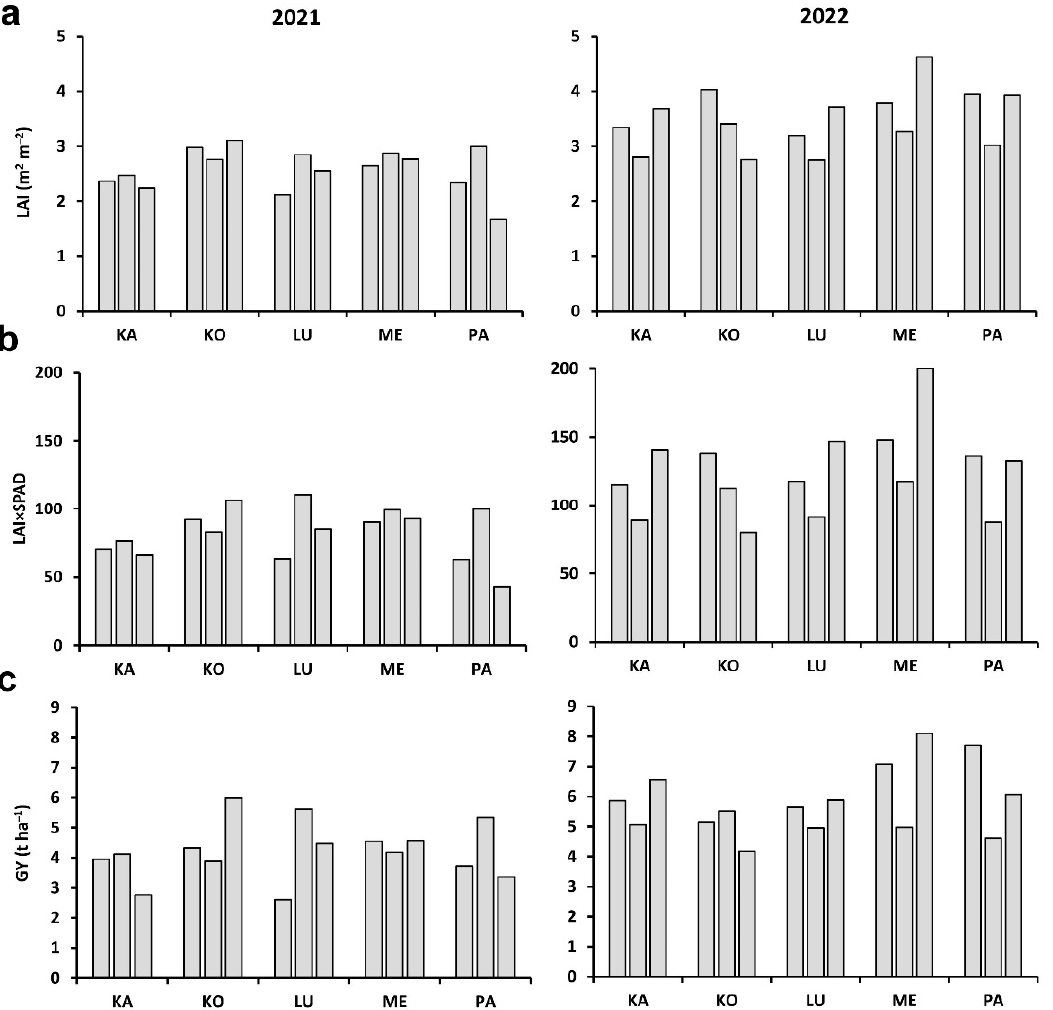
Figure 3. ( a ) Leaf area index (LAI), ( b ) LAI × SPAD (chlorophyll amount in flag leaf) value, and ( c ) grain yield (GY) for the five wheat cultivars (KA: Káplár; KO: Kolo; LU: Lucilla; ME: Ménrót; PA: Pántlika) in three replicate plots (A, B, and C from left to right) in two years.